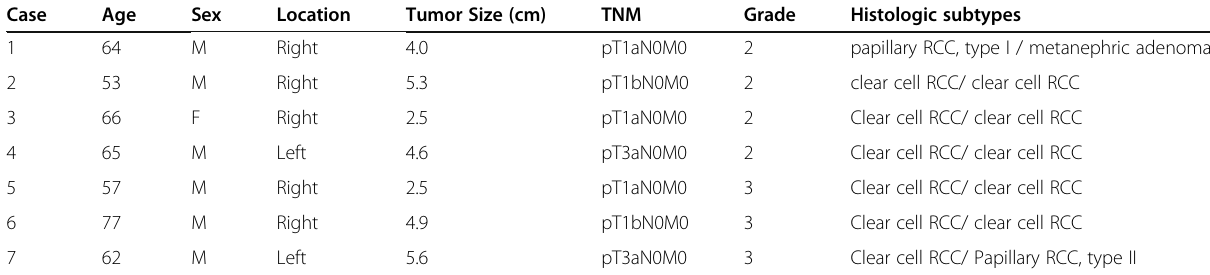
Table 1 Patient characteristics of ipsilateral multiple renal